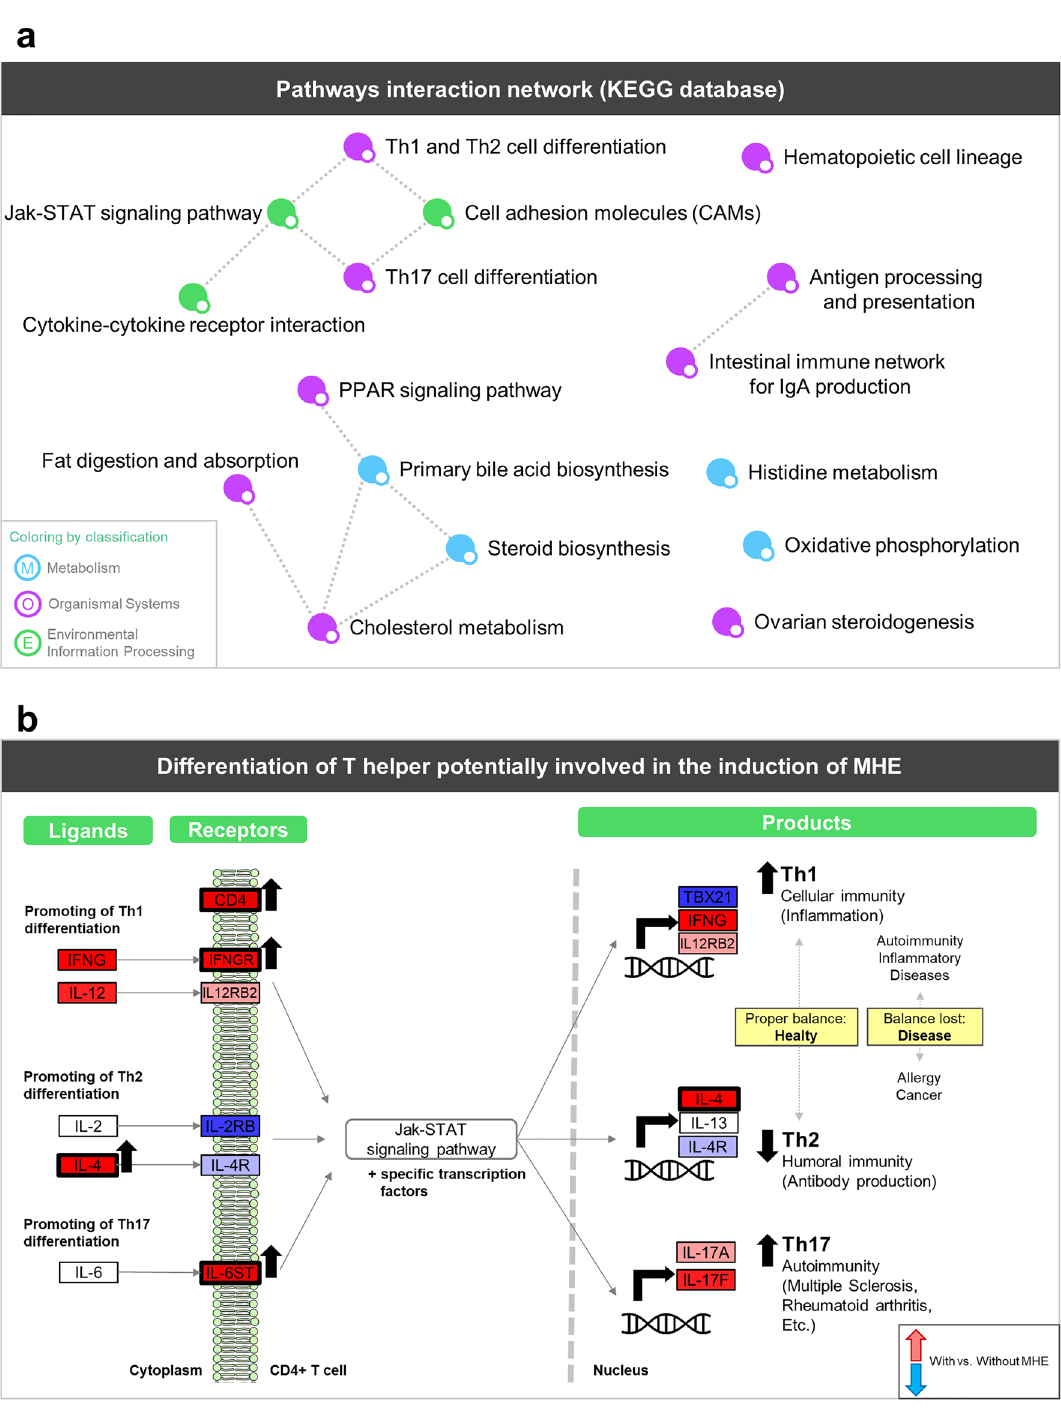
Figure 2. Summary of PaintOmics enrichment analysis. ( a ) Network showing pathway-pathway interactions in PaintOmics 3. Nodes represent pathways with a p-value lower than 0.05 and are colored by KEGG category. Edges between two nodes indicate that both biological processes are closely related. ( b ) Pathway scheme that summarizes Th1, Th2 and Th17 differentiation pathways. Rectangles represent up (red) or down (blue) gene regulation in patients with versus without MHE. Black arrows and thicker black borders mark those genes with statistical significance (FDR <